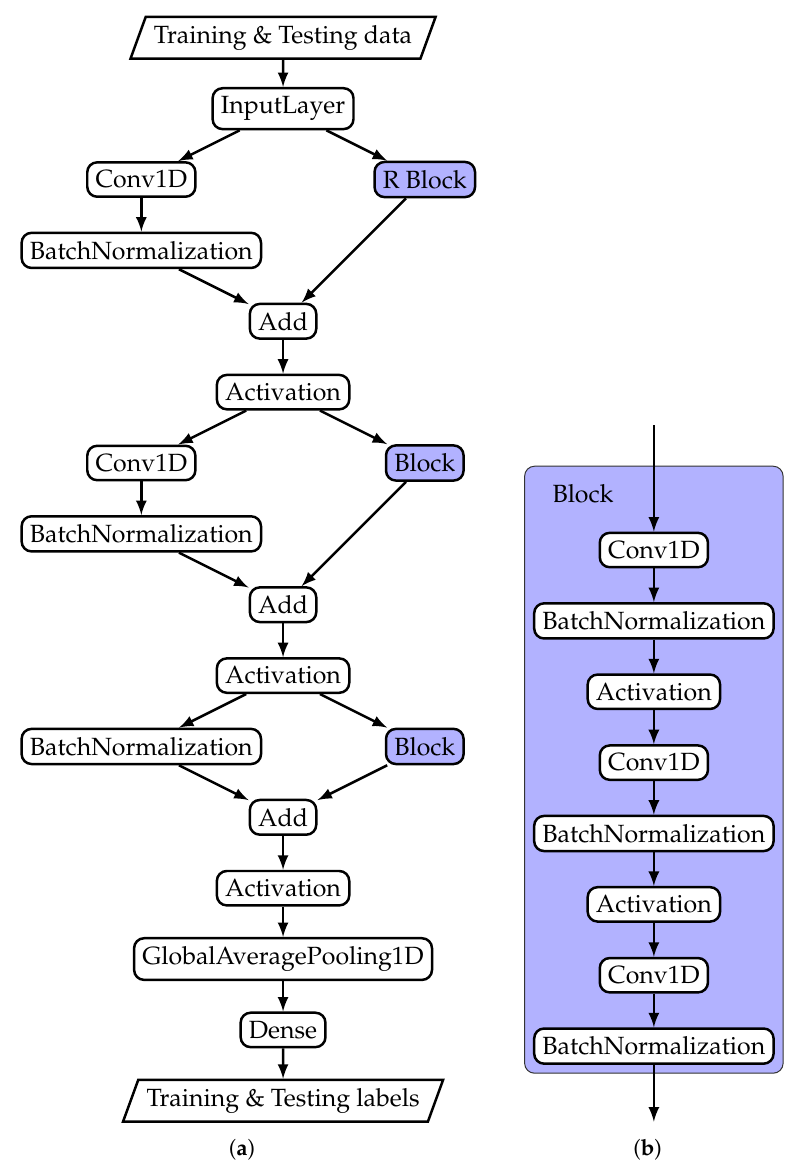
Figure 3. ResNet structure used for training and testing: ( a ) Network super structure; ( b ) Block structure. Table 4 provides the number of data vectors used to train and test the ResNet. In a final step, these data vectors were used to form 10-folds that contain train and test sets. Table 3 provides the parameters for these datasets. They were arranged by selecting one part for testing and using the data vectors in the remaining parts for training. That process was repeated until every part was used for testing. The fact that the number of class-specific data vectors is equal within each part (see Table 4) leads to perfectly balanced training datasets. That means for any given Test part, the number of data vectors for NSR, AFIB, and AFL is the same. To document the data arrangement process, Column 1 in Table 4 indicates the fold and the remaining columns on the right indicate the number of training and testing data vectors. For example, for fold 1, part 1 was used for testing, and hence, parts 2 to 10 were used for training. Based on that setup, the amount of training and testing data follows from the number of class specific data vectors in each part, as provided in Table 4. For fold 1, the network was trained with all the data vectors (53,823) from AFL SC (17,941), AFL P (17,941), and AFIB P (17,941). The network was tested with all data vectors in part 1 (8275): AFL SC (2226), NSR (2015), and AFIB